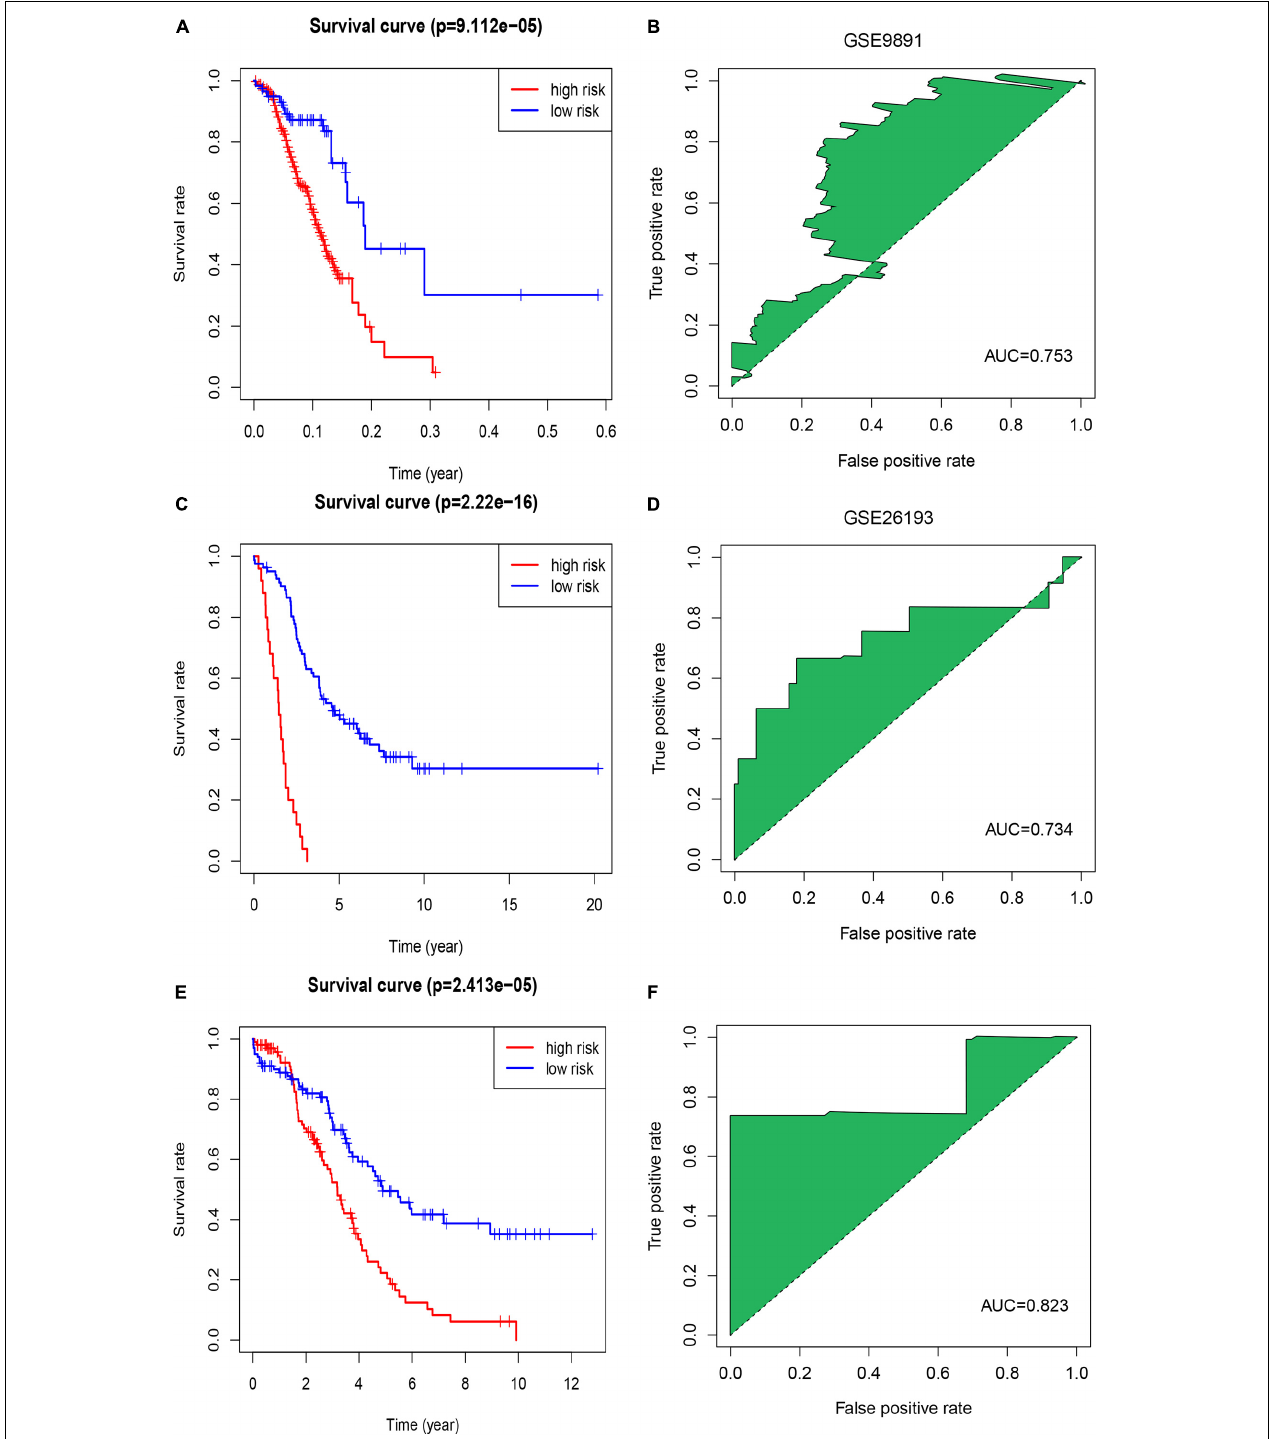
FIGURE 2 | Evaluation of the signature of seven immune-related lncRNAs in the GSE9891 and GSE26193 datasets. (A) The K-M survival curve shows the results of survival analysis for the signature of seven immune-related lncRNAs in the GSE9891 dataset. (B) ROC curve analysis of the signature of seven immune-related lncRNAs in the GSE9891 dataset. (C) The K-M survival curve shows results of survival analysis for the signature of seven immune-related lncRNAs in the GSE26193 dataset. (D) ROC curve analysis of the signature of seven immune-related lncRNAs in the GSE26193 dataset. (E) The K-M survival curve shows the results of survival analysis for the signature of seven immune-related lncRNAs in our clinical specimens. (F) ROC curve analysis of the signature of seven immune-related lncRNAs in our clinical specimens.